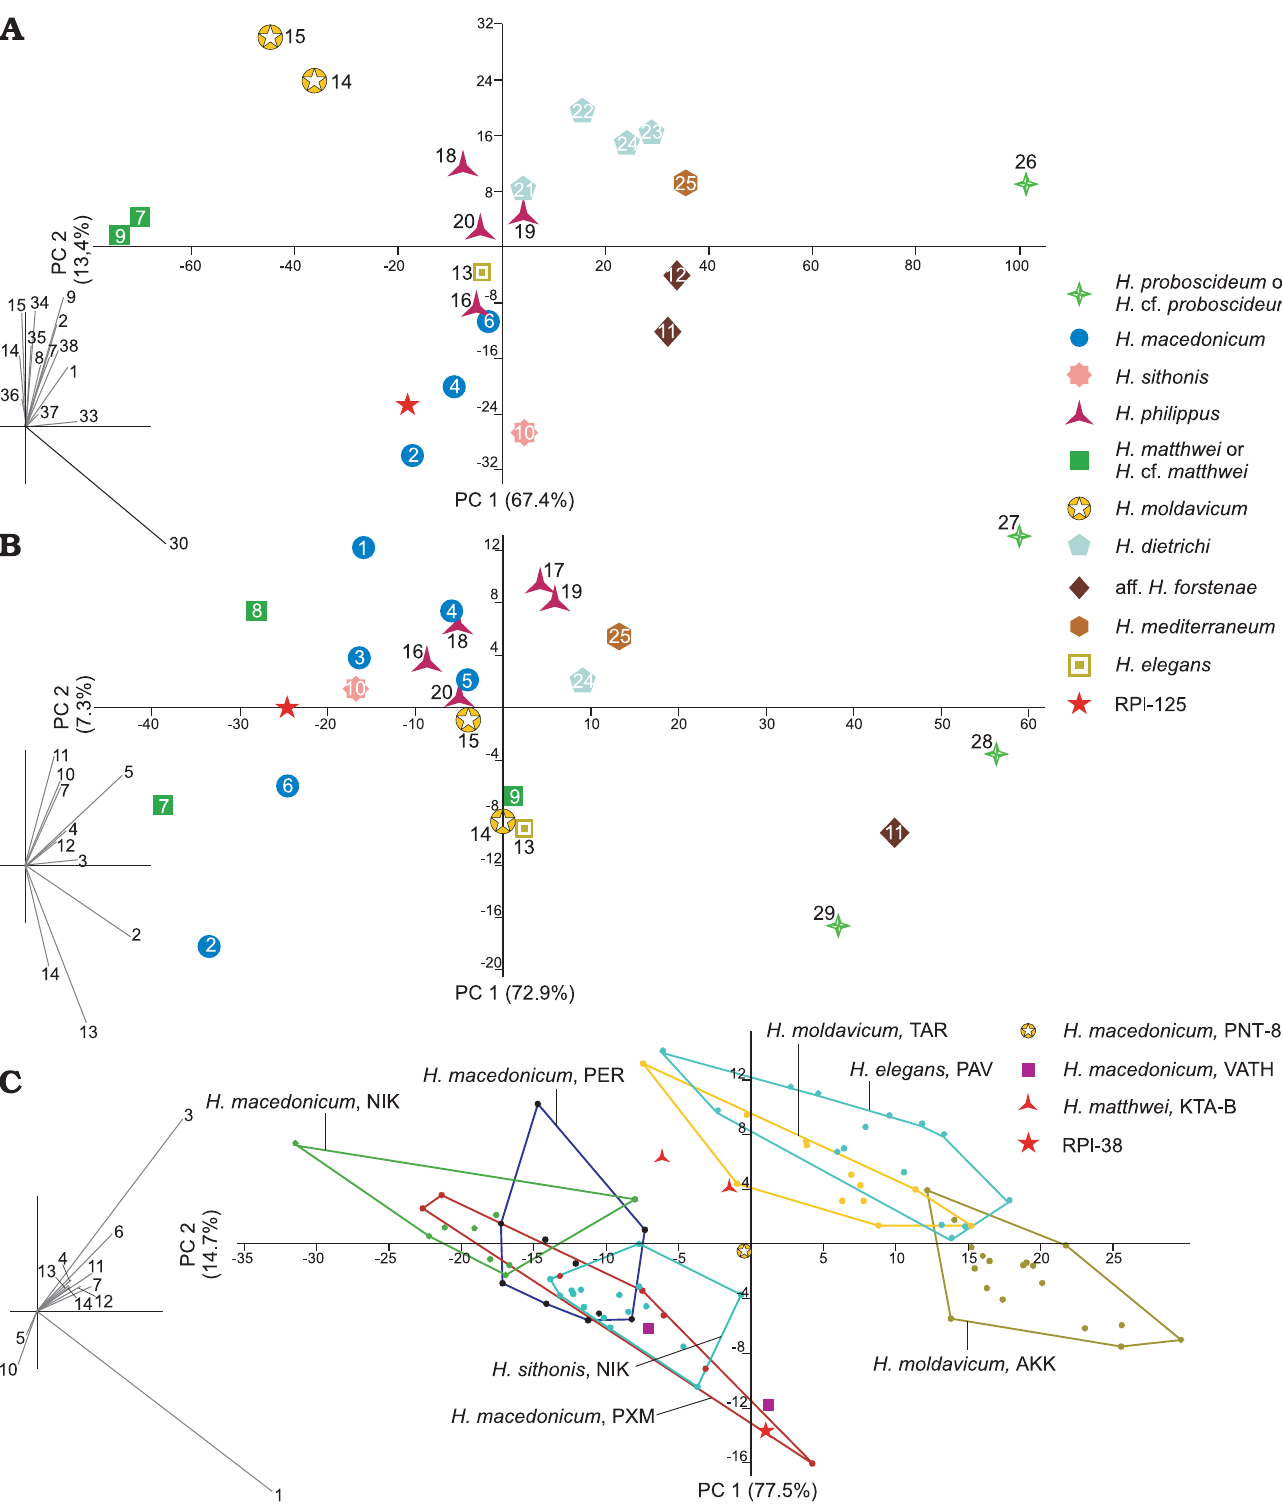
Fig. 4. Principal component analysis of the skull ( A ), mandible ( B ), and third metatarsal ( C ) of the RPl small-sized hipparion in comparison with other small-sized forms of Eurasia, indicating its strong size-similarities with Hipparion macedonicum. As the available specimens are fragmentary, lacking measurements the mean cranial dimensions for each locality are used. The used variables (various measurements of the skull, mandible and Mt III ) and their influence to the distinction of the specimens is given in the left part of the diagrams. The convex hulls indicate the allocation of the measurements in the space for its sample. Hipparion dietrichi , Hipparion mediterraneum , and Hipparion proboscideum or Hipparion cf. proboscideum are used as comparative samples. Hipparion macedonicum : 1, NKT; 2, NIK; 3, RZO; 4, PXM; 5, VATH; 6, PER. Hipparion matthewi : 7, Samos (unknown locality), holotype; 8, KTA-B. Hipparion cf. matthwei : 9, MTLA. Hipparion sithonis : 10, NIK. aff. Hipparion forstenae : 11, MTLA; 12, Samos Q1. Hipparion